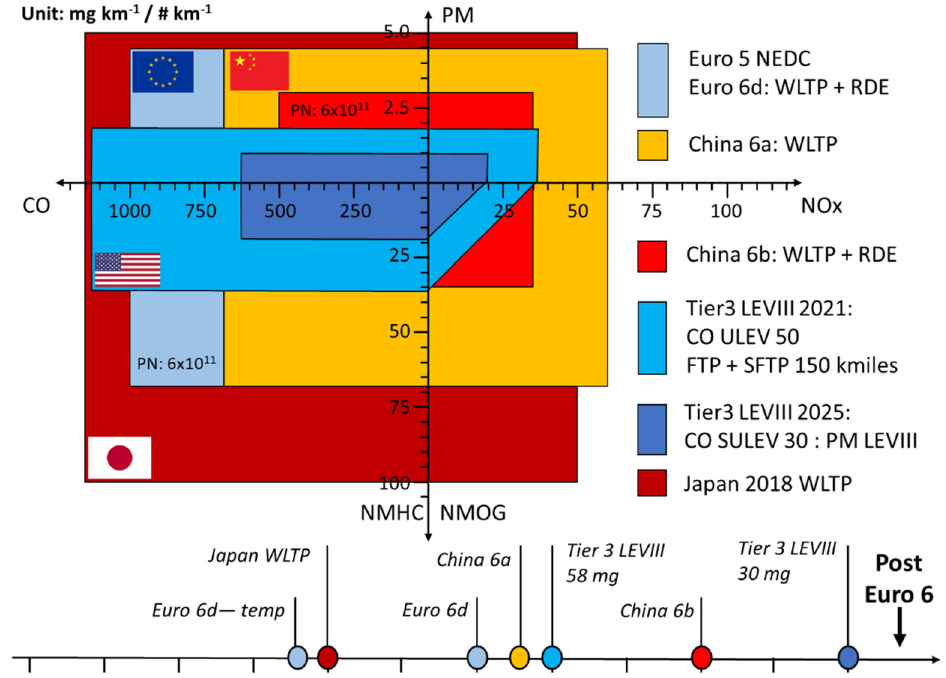
Figure 1. Simplified diagram of emission limits and phase-in timing in four of the main world regions (LEV: low—emission vehicle, ULEV: ultra-low-emission vehicle, WLTP: World LDV Test Procedure, FTP: Federal Test Procedure, SFTP: supplemental FTP, and RDE: real driving emissions).